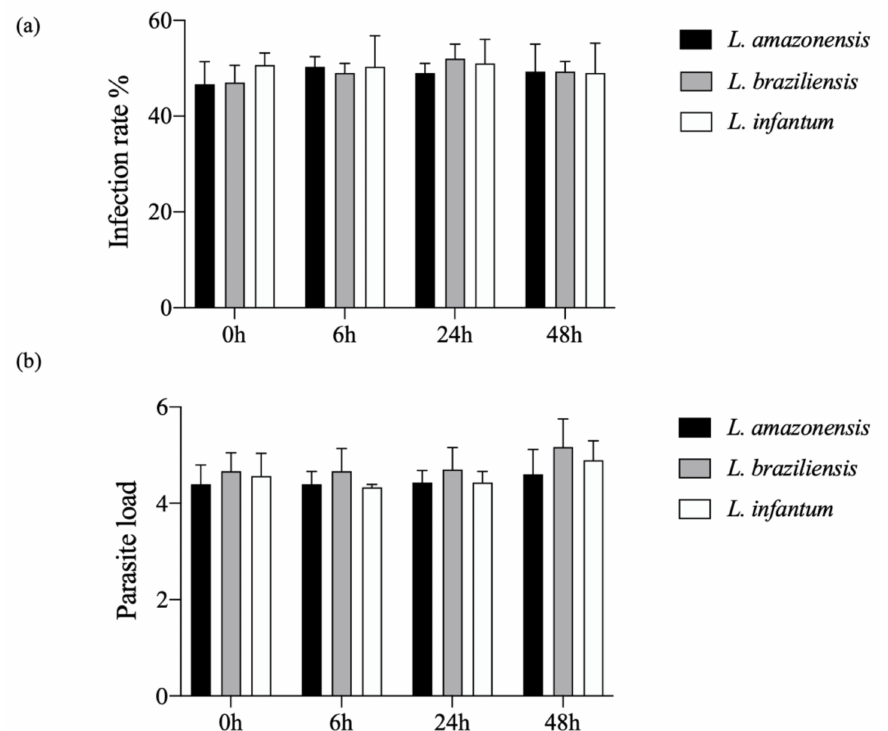
Figure 1. Kinetics of hDC infection with L. amazonensis , L. braziliensis or L. infantum . Human dendritic cells were infected with L. amazonensis (10:1), L. braziliensis (10:1) or L. infantum (20:1) for 4 h. ( a ) Percentage of infection; ( b ) parasitic burden in 400 cells randomly evaluated by fluorescence microscopy. (Student’s t -test). Data are representative of three independent